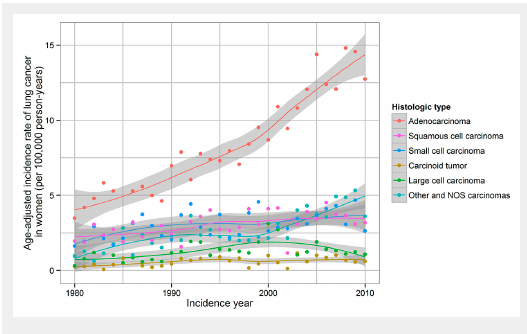
Trends in lung cancer incidence in men by histological type in the Canton of Zurich, Switzerland, 1980–2010. Rates are age adjusted to the standard European population.